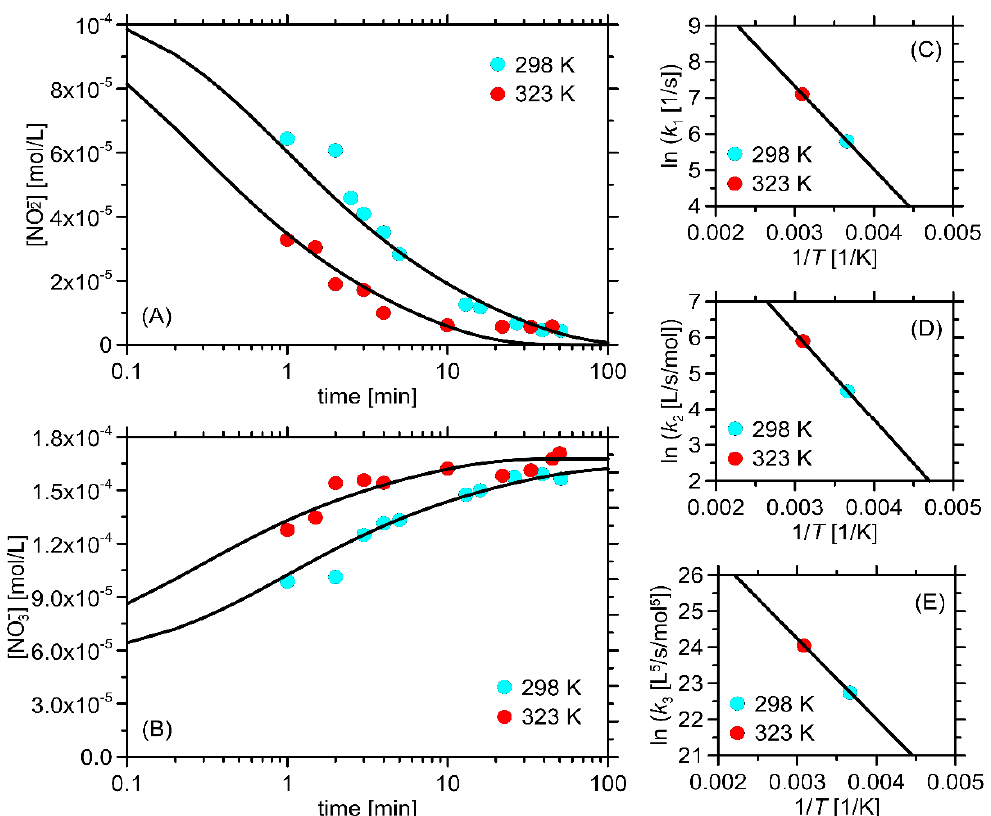
Figure 5. The dependences of ( A ) the decreasing concentration of NO 3 − over time, ( B ) the increasing concentration of NO 2 − over time. The logarithmic scale was applied for clarity. ( C , D , E ) The Arrhenius plots (i.e., the dependence of the logarithm of the rate constants (k 1–3 ) on the reciprocal of the absolute temperature) for the three reaction stages. The initial concentration of NO 2 − is equal to 0.11 mmol L − 1 , whereas that of NO 3 − equals 0.16 mmol L − 1 . The concentrations of KMnO 4 and H + are constant and equal to 0.05 mmol L − 1 and 11.46 mmol L − 1 , respectively. The points correspond to the experimental data, whereas the solid lines correspond to the predictions of the corresponding rate equation (proposed in [34]).